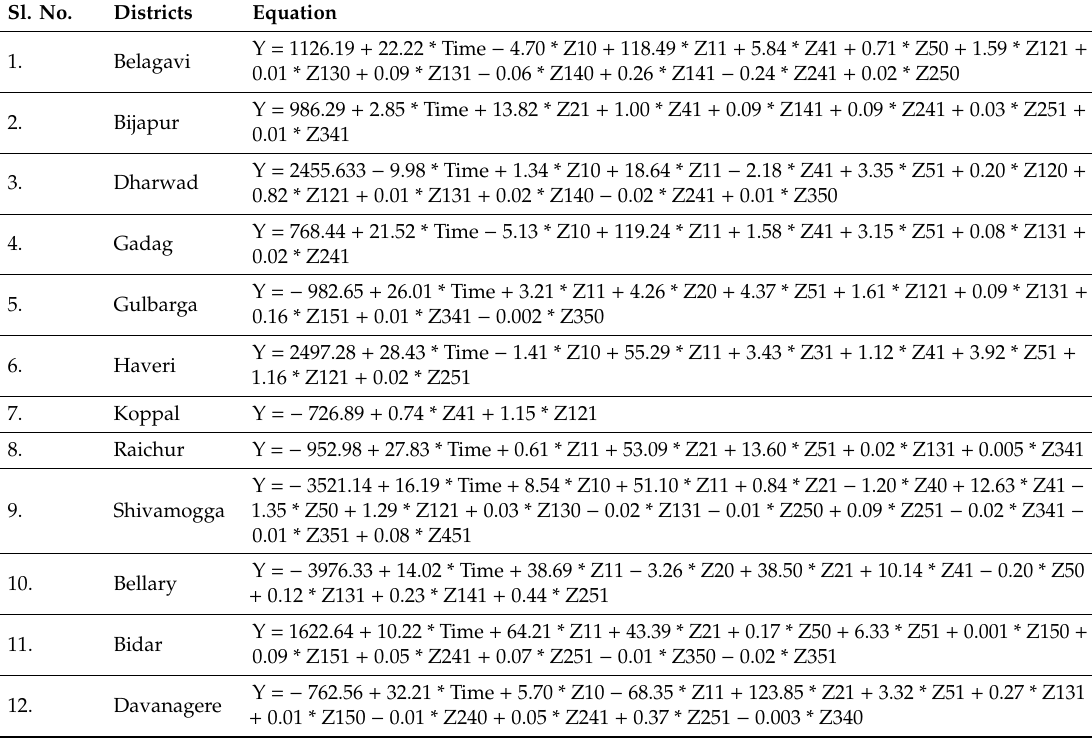
Table A1. Yield predicting equations derived from LASSO for major sorghum growing districts of Karnataka without